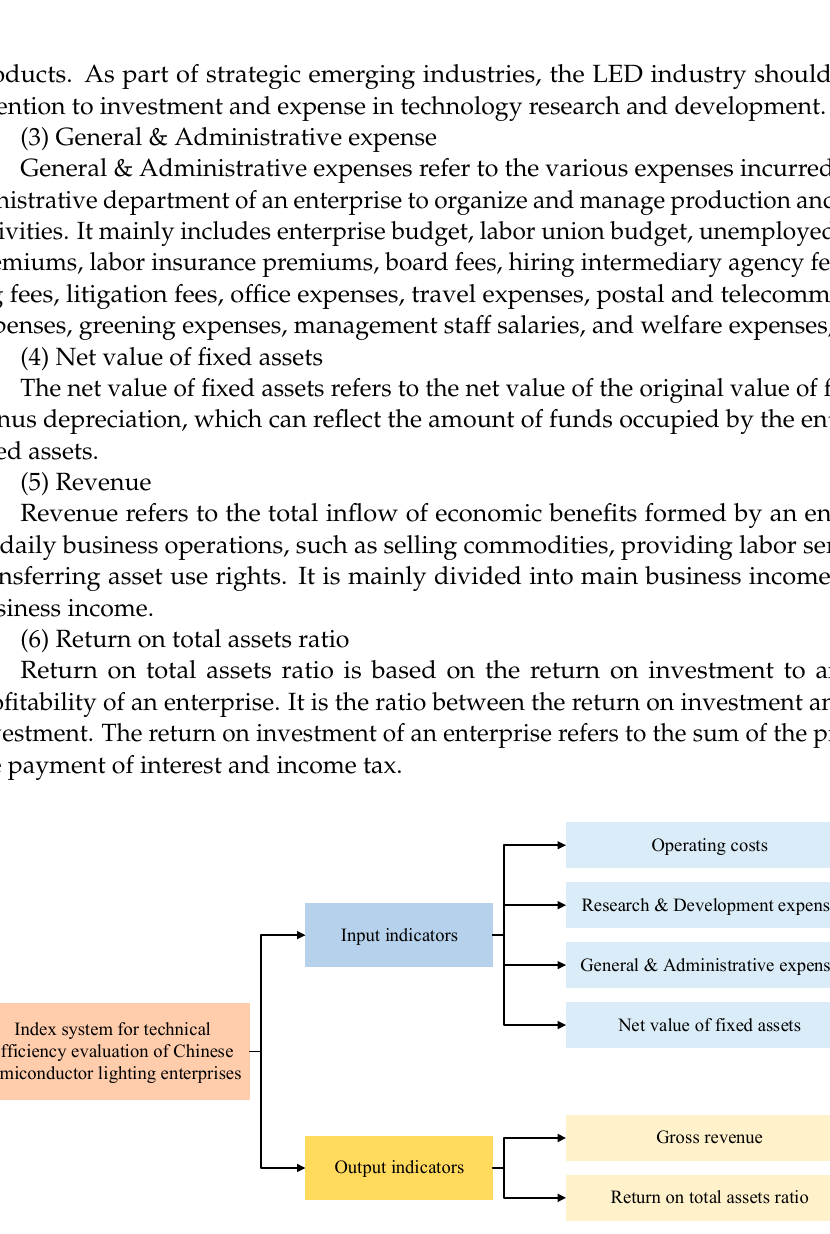
Figure 4. The index system for efficiency evaluation of Chinese LED energy enterprises.